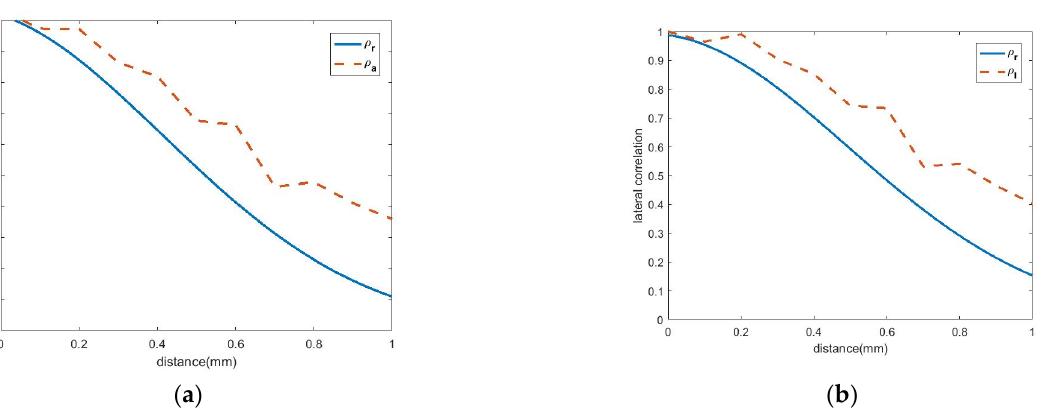
Figure 16. Displacement correlation coefficient of dataset DB1. ( a ) axial; ( b ) lateral.